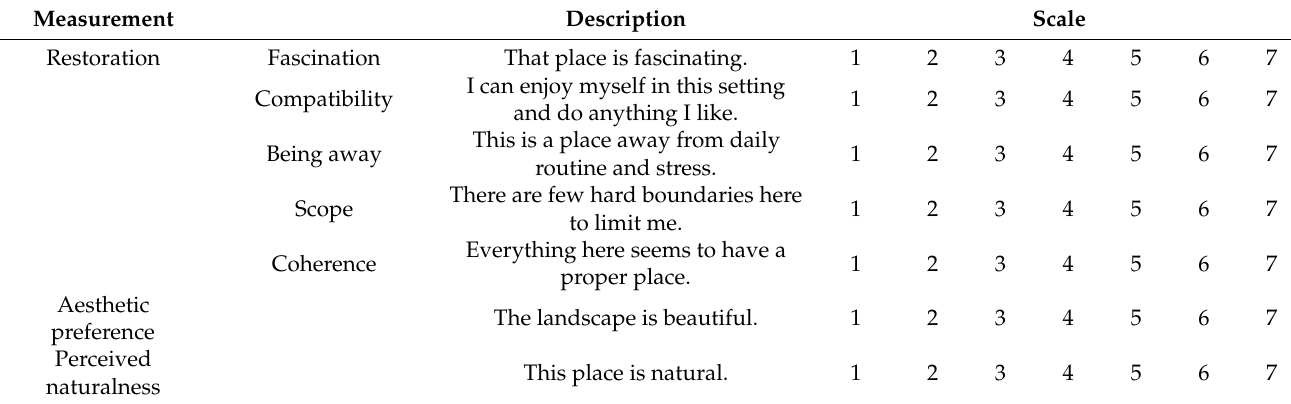
Table 2. Restoration, aesthetic preference, and perceived naturalness scale for the UPBS.